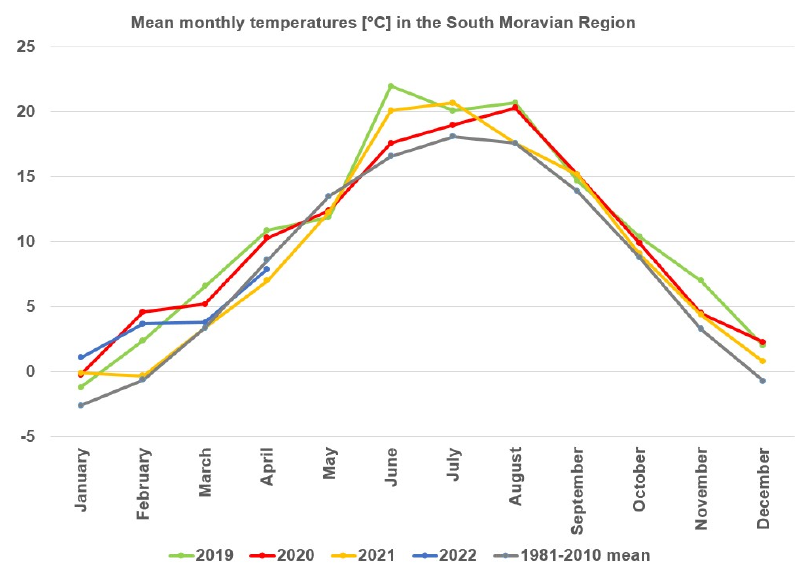
Figure 11. Mean monthly temperatures in the southern Moravian region in 2019, 2020, 2021, 2022, and long-term 1981–2020 monthly means. Source: Czech Hydrometeorological Institute, https://www.chmi.cz/historicka-data/pocasi/uzemni-teploty (accessed on 30 May 2022; in Czech).